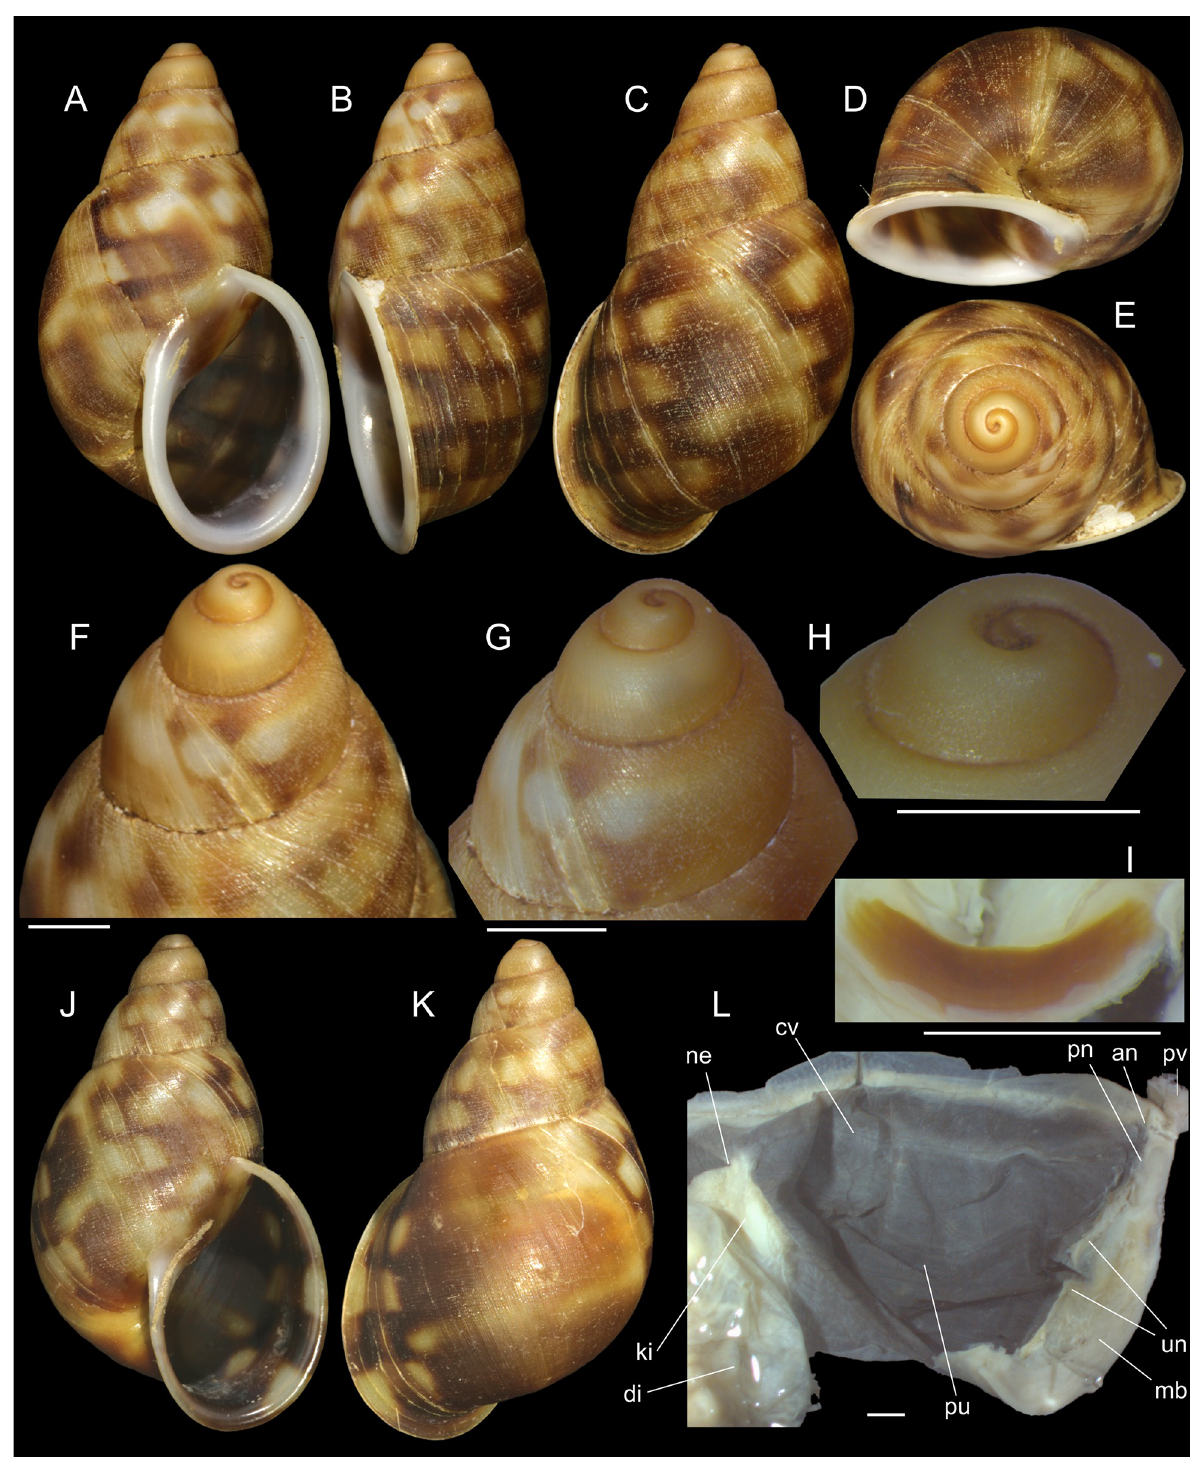
Fig 13. Anthinus morenus , shell of some types and anatomy. (A-H) Holotype MZSP 152891 (L 35.8 mm). (A) Frontal view. (B) Right view. (C) Dorsal view. (D) Anterior view (W 21.0 mm). (E) Apical view. (F) Detail of protoconch and fist teleoconch whorl, profile. (G) Same, higher magnification. (H) Same, detail of apex. (I-L) Paratype MZSP 152047#1. (I) Jaw, in situ, ventral view. (J) Shell, frontal view (L 34.8 mm). (K) Shell, dorsal view. (L) Pallial cavity, ventral view, dorsal part of mantle edge and deflected to right, part of mantle floor also shown. Scales = 2 mm.